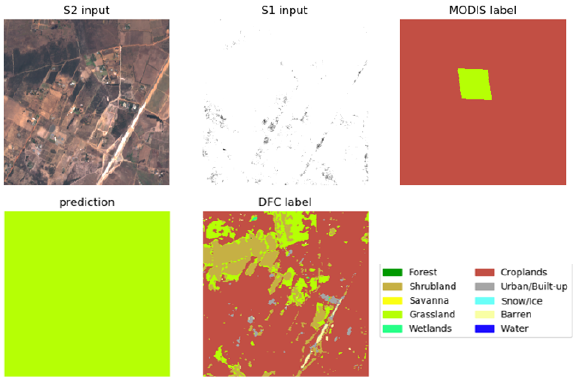
Figure 9: Misclassification of cropland and